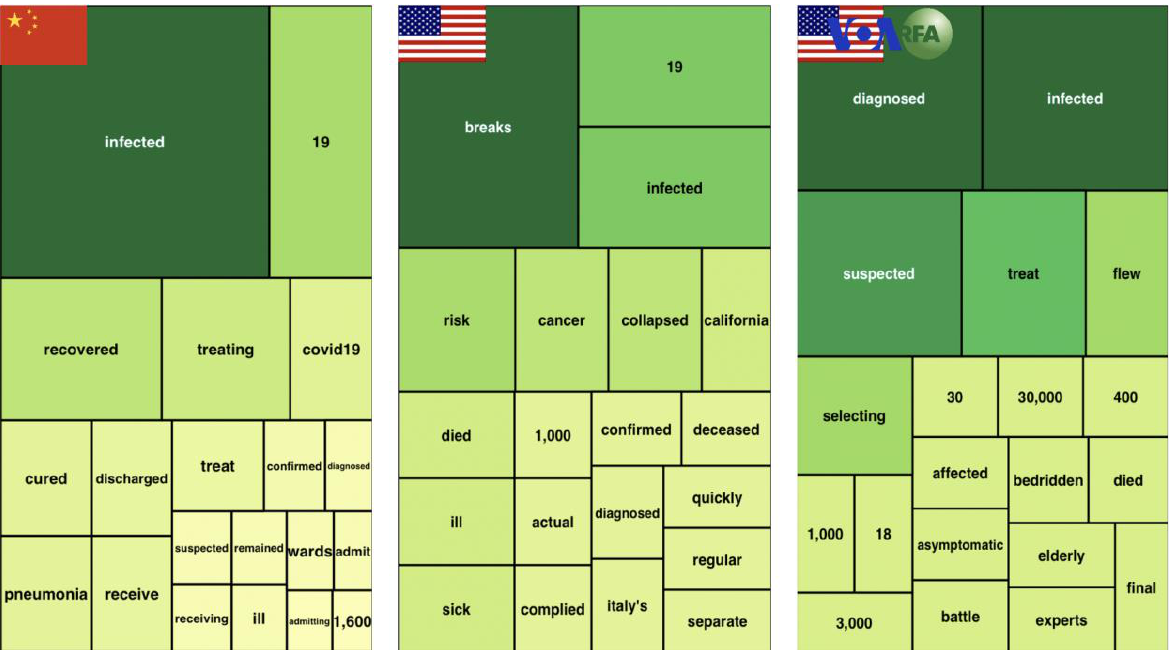
Figure 2 : Top 20 most frequently used words in connection with the word “patient” by Chinese media (left), U.S. mainstream media (middle) and U.S. government-funded media (right); Excluding the term “coronavirus” for better visibility of other terms. Larger area size and darker color indicate a more frequent term usage. Chinese media use more recovery- and treatment-related words than U.S.